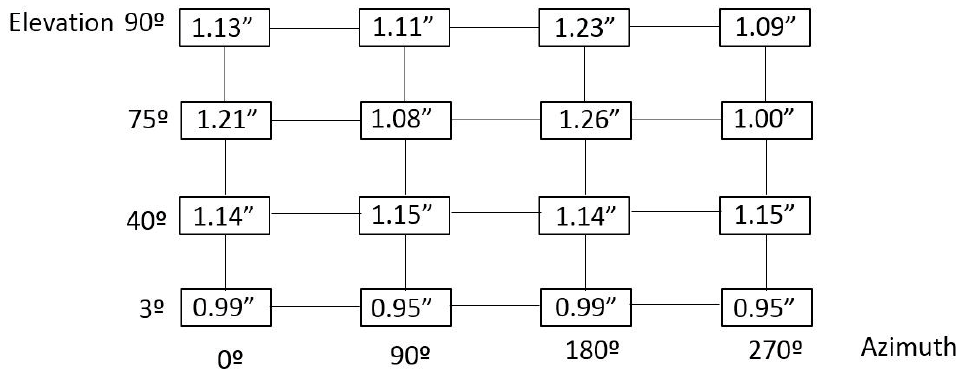
Figure 6. Improved RPE measurement uncertainty results (in arcseconds).